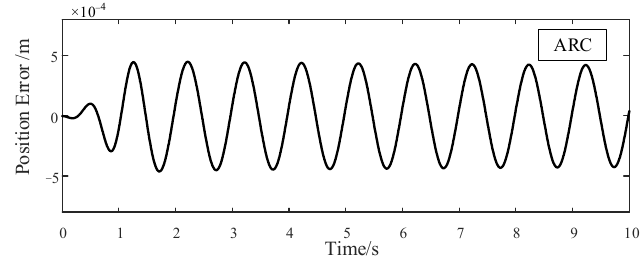
Figure 9. ARC Tracking Error of 1 Hz Sinusoidal Signal.